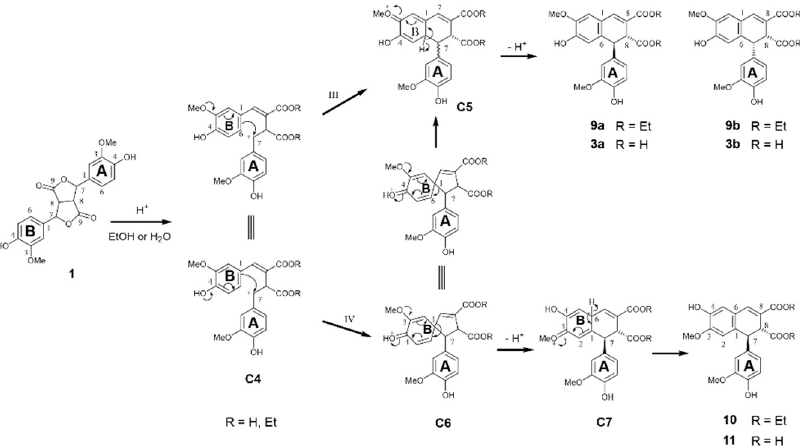
Figure 7. Proposed mechanisms involved in acid treatment of FA dilactone leading to the formation of compounds 10 and 11 .